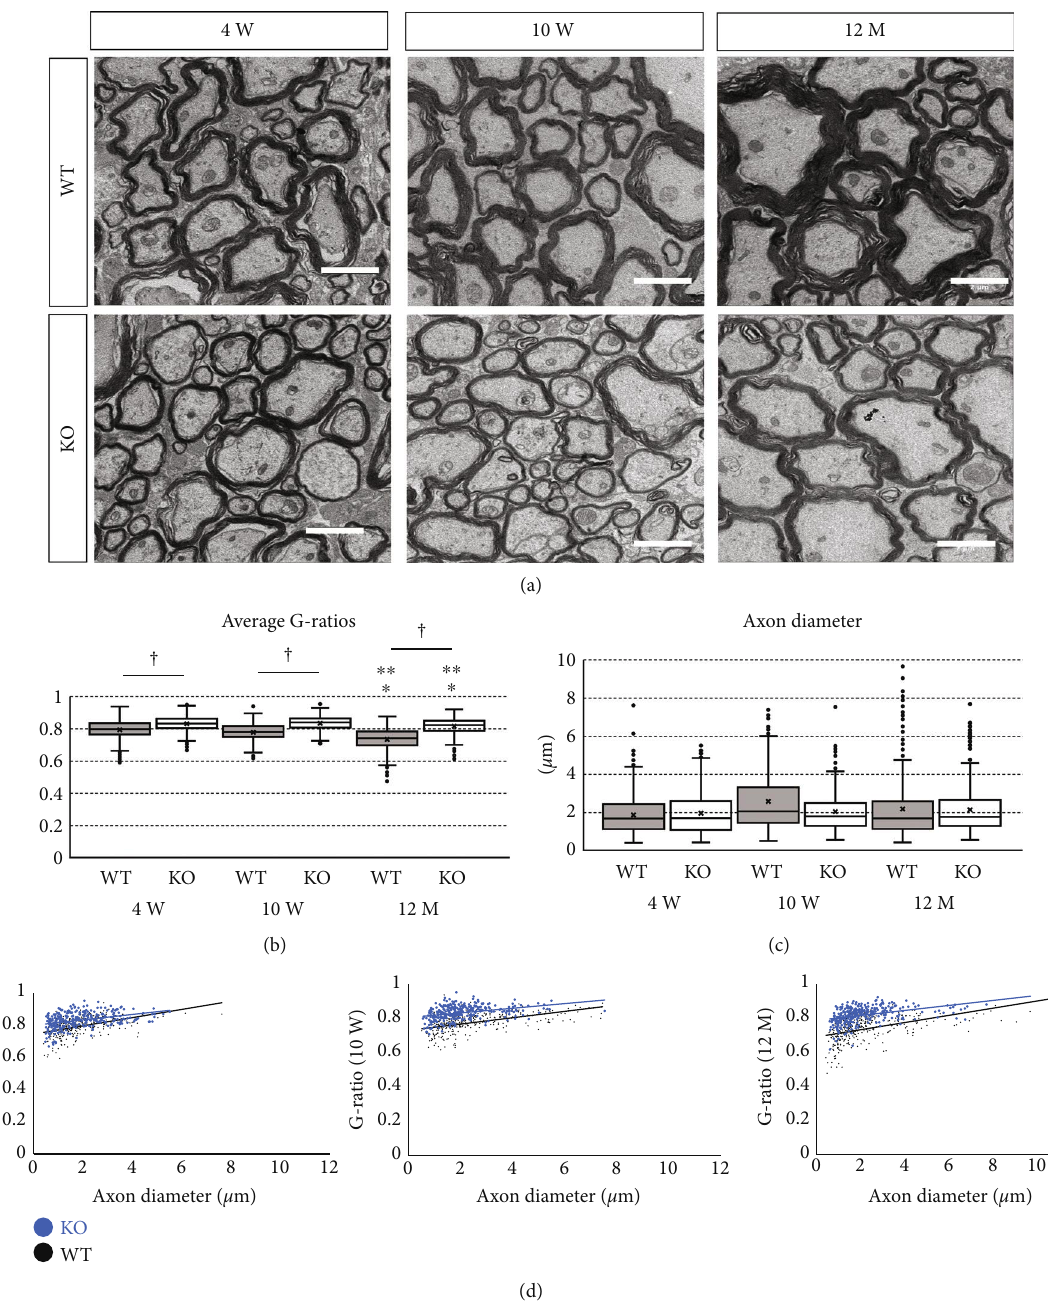
Figure 5: Evaluation of myelin sheath by electron microscopy. Wild-type (WT) and miR-23-27-24 cluster knockout (KO), 150-200 axons per mouse, n = 3 per group. (a) Electron micrograph of the transverse section of the spinal cord in WT and KO mice at 4 weeks, 10 weeks, and 12 months of age. Scale bars: 2 μ m. (b) The ratio of the diameter of the axon without myelin sheath to the diameter of the axon with myelin sheath (G-ratio) was used to evaluate the thickness of the myelin sheath. G-ratio in 12-month-old mice was signi fi cantly lower than that in 4- and 10-week-old WT and KO mice. G-ratio in 10-week-old WT mice was signi fi cantly lower than that in 4-week-old WT mice. G- ratio in KO mice was signi fi cantly higher than that in WT mice at all ages. ∗ Compared to 4-week-old. ∗∗ Compared to 10-week-old. † Comparison between WT and KO mice, p < 0 : 05 . (c) There was no signi fi cant di ff erence in axon diameter between WT and KO mice or between mice of di ff erent ages. (d) Regardless of the axon diameter, the G-ratio in KO mice was higher than that in WT mice at all